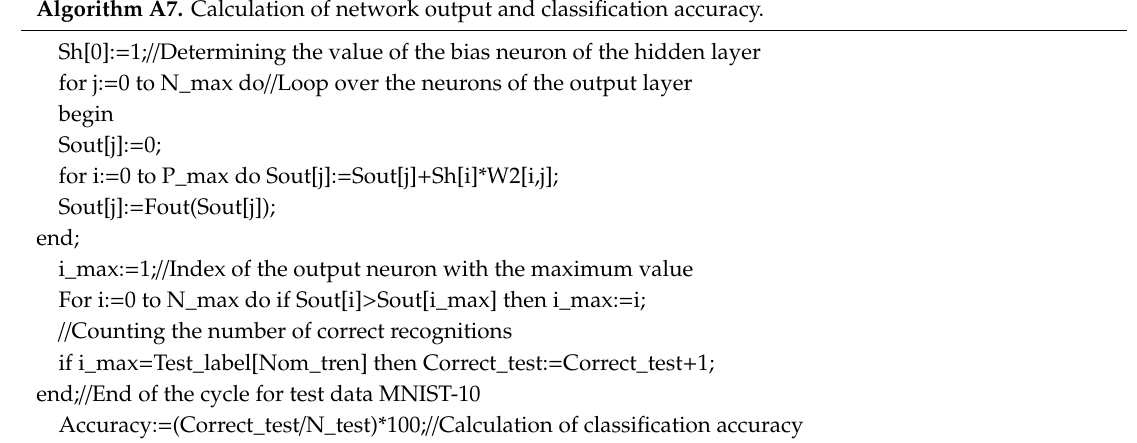
Algorithm A7. Calculation of network output and classification